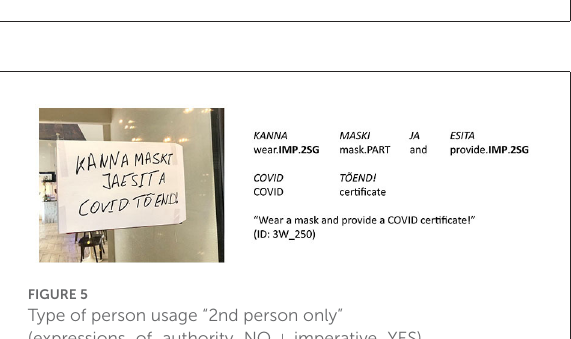
FIGURE5 Type of person usage “2nd person